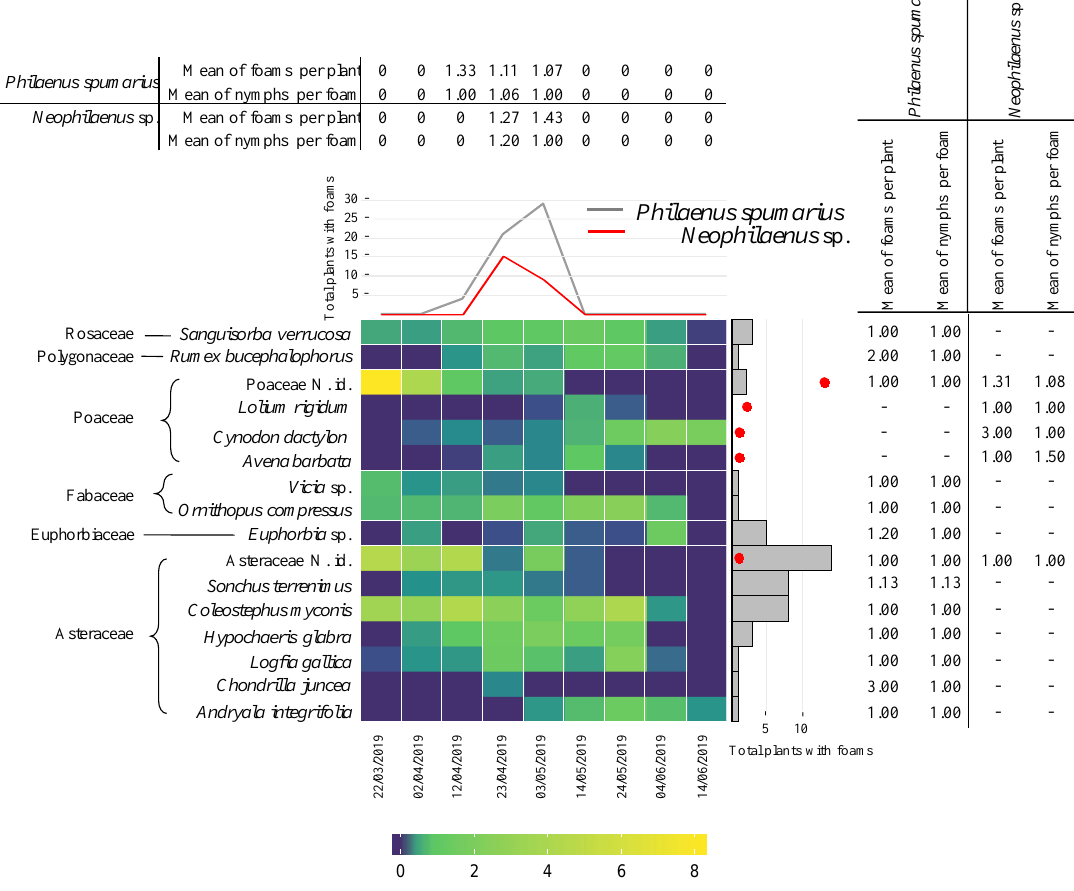
Figure 5. Heatmap plot showing 2019 data: ( i ) the percentage of plants with foam of all plants within a taxon (dark purple to yellow) (only host plants shown); ( ii ) total plants with foams of Philaenus spumarius (grey line) and Neophilaenus sp. (red line) during the collection period (top graphs); ( iii ) the total plants with P. spumarius (bars) and Neophilaenus sp. (points) foams in the identified plants (right graph); ( iv ) mean foams of P. spumarius and Neophilaenus sp. per plant and date; and ( v ) mean nymphs per foam of P. spumarius and Neophilaenus sp. per plant and date in a productive integrated olive orchard (P). N. id after taxa means not identified specimens belonging to that group. Families are indicated at the left of the plant species.